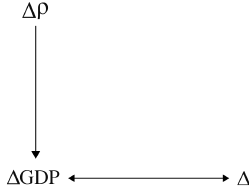
Figure 3. Granger casual relationship between ˆ ρ t and real